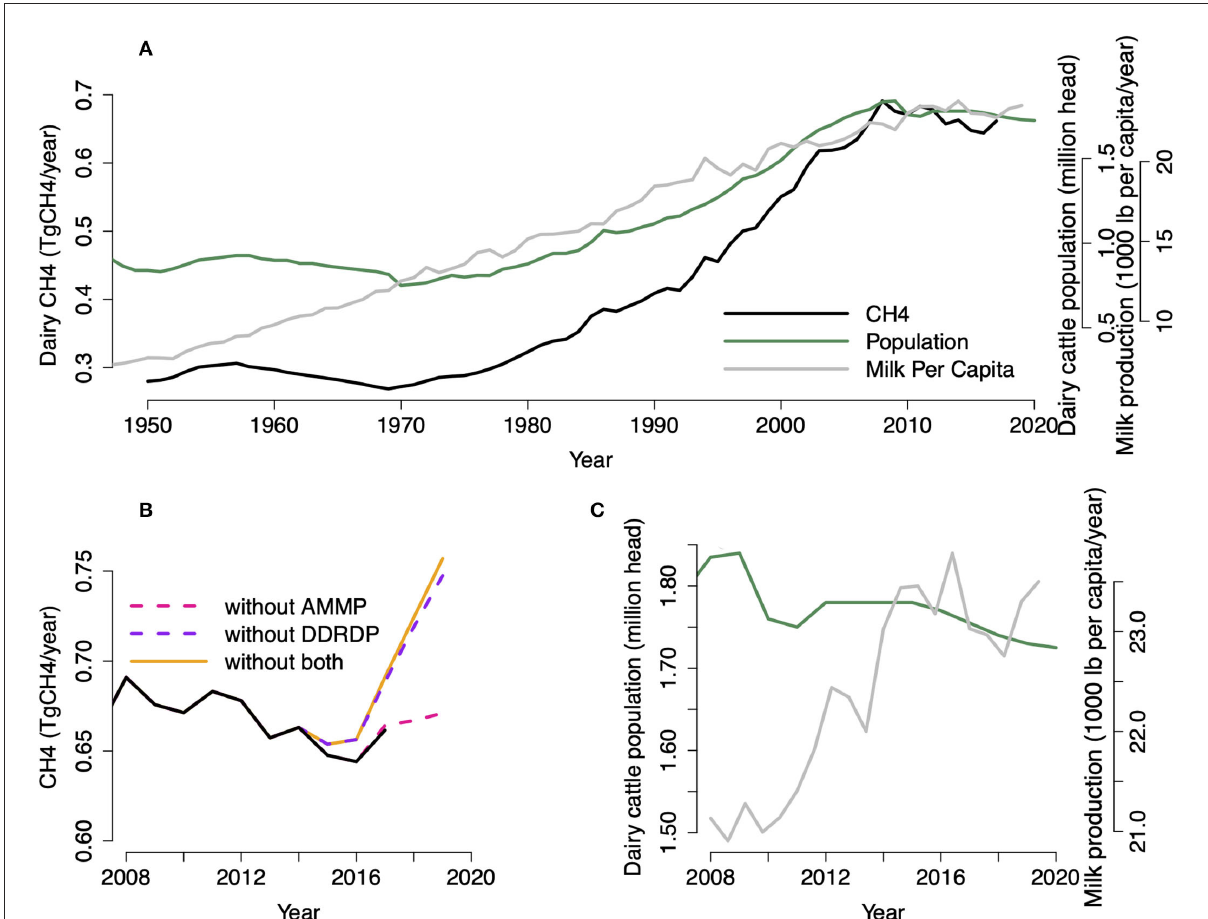
FIGURE7 Mechanisms of decreasing CH 4 emissions since 2008 include decreasing dairy herd size, increasing per capita production, and manure management CH 4 reductions programs. In (A–C) , the x -axis shows years; in (A) the entire historical time series is shown (1950–2017), while in (B, C) , only 2008–2017 are shown. In (A, B) , the y -axis is annual total dairy CH 4 emissions, but in (B) the y -axis does not begin at zero in order to provide a close-up view of CH 4 dynamics from 2008 to 2017. In (A) , the right y axis shows per capita milk production and cattle population. (B) Shows hypothetical estimates of annual CH 4 reductions due to DDRDP and AMMP program implementation, which has been added to historical CH 4 emissions to plot putative emissions without these programs. The y -axis of (C) shows cattle population and the right y axis shows per capita milk